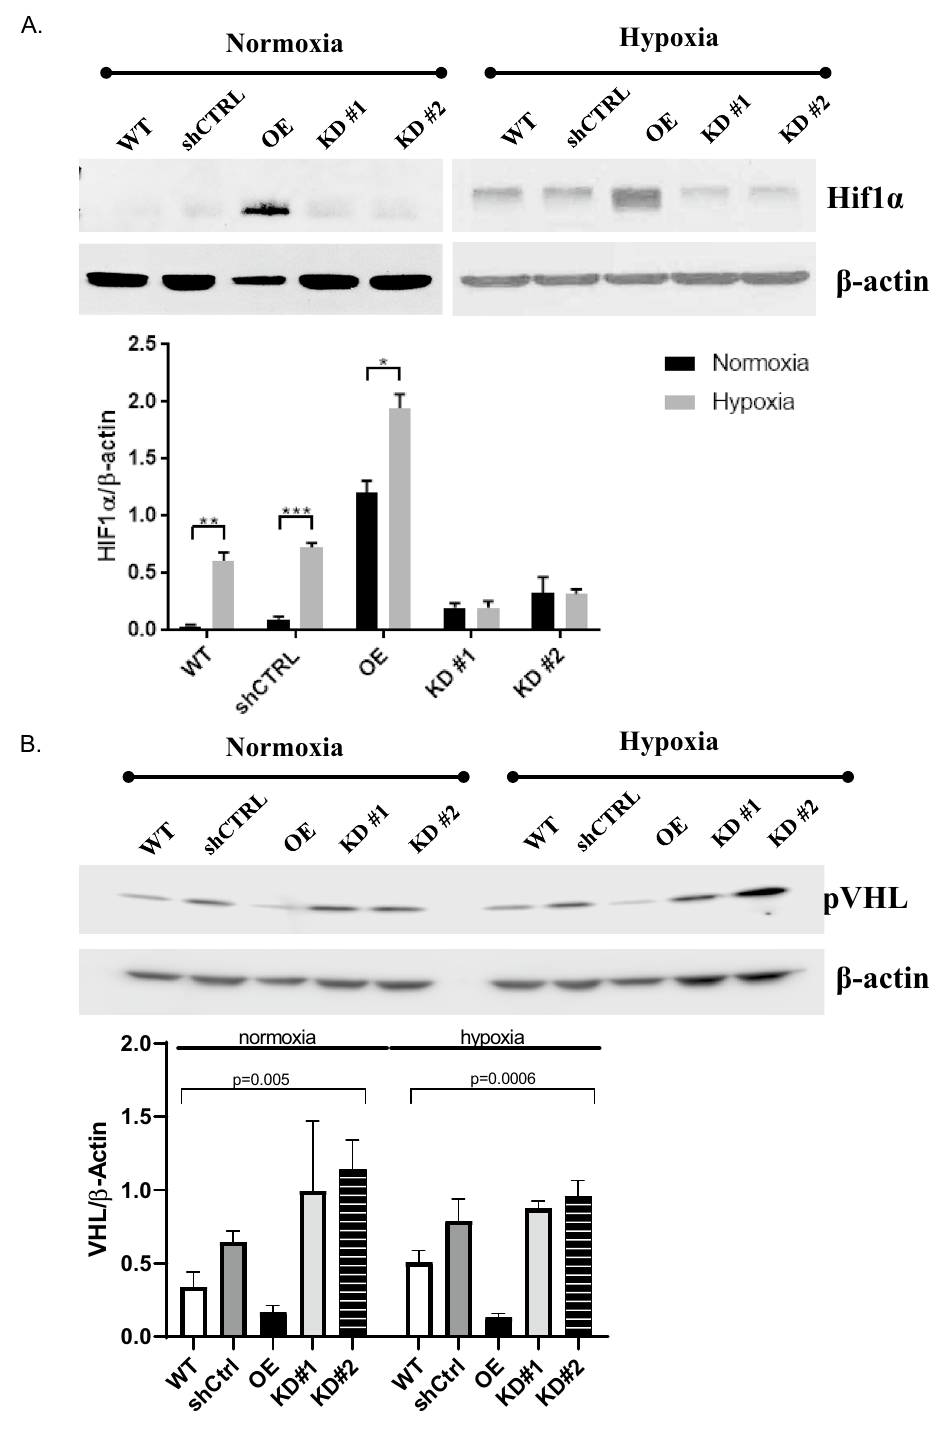
Figure 5. EMP2 expression modulates HIF1α and VEGF protein expression. ( A , B ) Analysis of HIF1α or VHL protein expression in WT, shRNA control (shCTRL), OE, shRNA KD #1, and shRNA KD#2 ARPE-19 cells under normoxic or hypoxic (0.5% O2 for 2–4 h) conditions, respectively. Quantification of protein expression under hypoxic conditions was determined using the LI-Cor Odyssey FC machine with images visualized using Image Studio software (Ver. 5.2). Expression of HIF1α or VHL was normalized to beta actin, for a minimum of 3 independent replicates. Bar diagrams depict mean values and standard error of the mean. Statistical significance was established using Student’s t -test (unpaired, two-tailed) for HIF1a or a one-way ANOVA for pVHL. Original, uncropped blots are presented in Supplementary Fig.